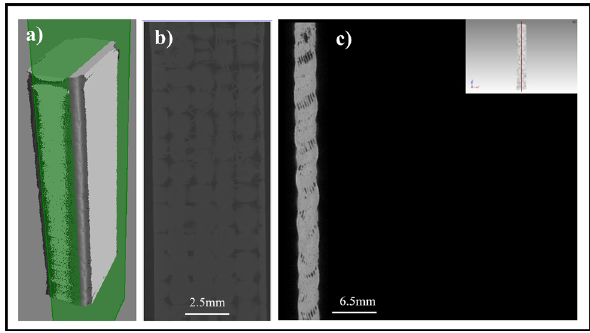
Figure 1: Micro - CT scan photo ( a ) scan location; ( b ) front view; and ( c ) side view.